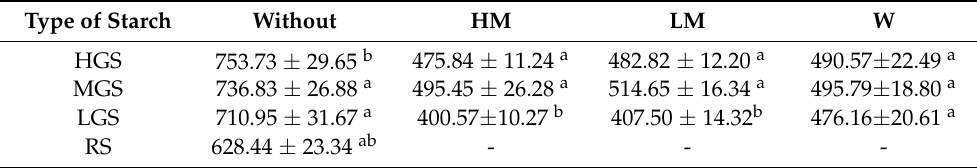
Table 4. Gel strength of starch pastes with different DSG reheated by different methods. Type of